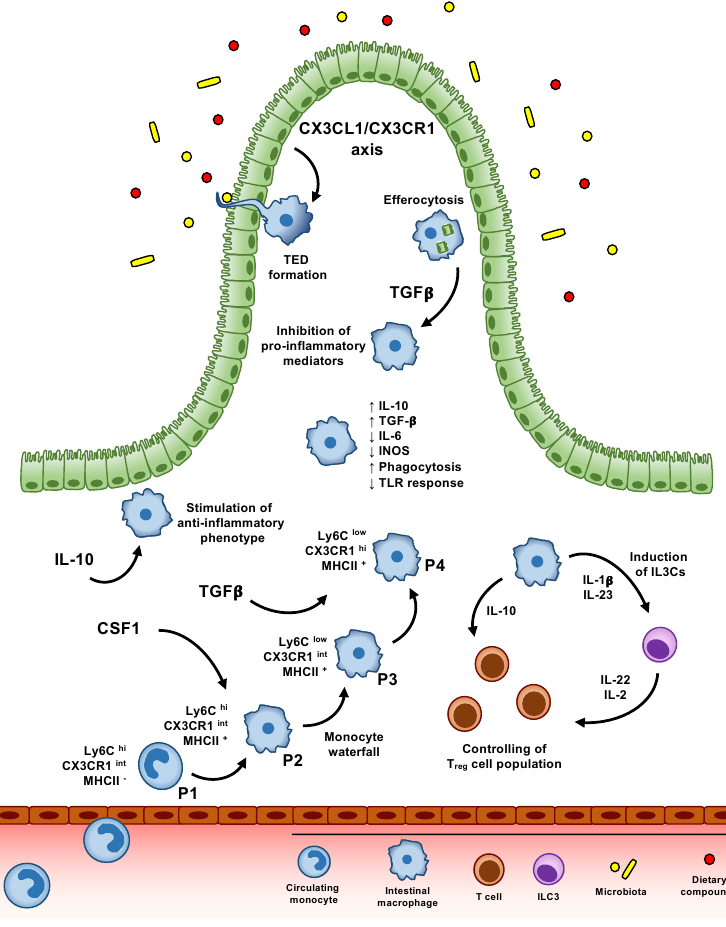
Figure 1. Factors shaping intestinal macrophage phenotype and function. Intestinal macrophages derive from circulating monocytes that, once in the gut, di ff erentiate into macrophages in a process known as monocyte “waterfall”: Ly6C hi CX3CR1 int MHCII − (P1) monocytes enter the intestinal tissue, acquire the expression of MHCII (P2), downregulate Ly6C(P3), and, finally, upregulate the expression of CX3CR1, becoming mature macrophages (P4). In homeostatic condition, intestinal macrophages show a pro-resolving phenotype, characterized by an increased production of anti-inflammatory molecules, such as IL-10 and TGF- β , reduced expression of pro-inflammatory mediators, including IL-6 and iNOS, hypo-responsiveness to TLR stimulation, higher phagocytic activity and support of T reg cell expansion. CSF1 is the primary cytokine involved in the di ff erentiation and survival of gut macrophages, while TGF β / TGF β -receptor axis is fundamental for their terminal di ff erentiation, modulating the expression of genes associated with their homeostatic phenotype. In addition, TGF β is released by macrophages after e ff erocytosis and phagocytosis of apoptotic cells, inhibiting, through a paracrine / autocrine mechanism, the secretion of proinflammatory mediators by macrophages themselves. Response to IL-10 stimulation is crucial to induce the anti-inflammatory profile of gut macrophages. CX3CR1 expressing macrophages are able to control T reg cell population, directly through the secretion of IL-10, or through the stimulation of ILC3. CX3CR1-macrophages, close to CX3CL1-expressing epithelial cells, extend trans-epithelial dendrites (TEDs) across the epithelial layer and capture soluble antigens or potential pathogens within the